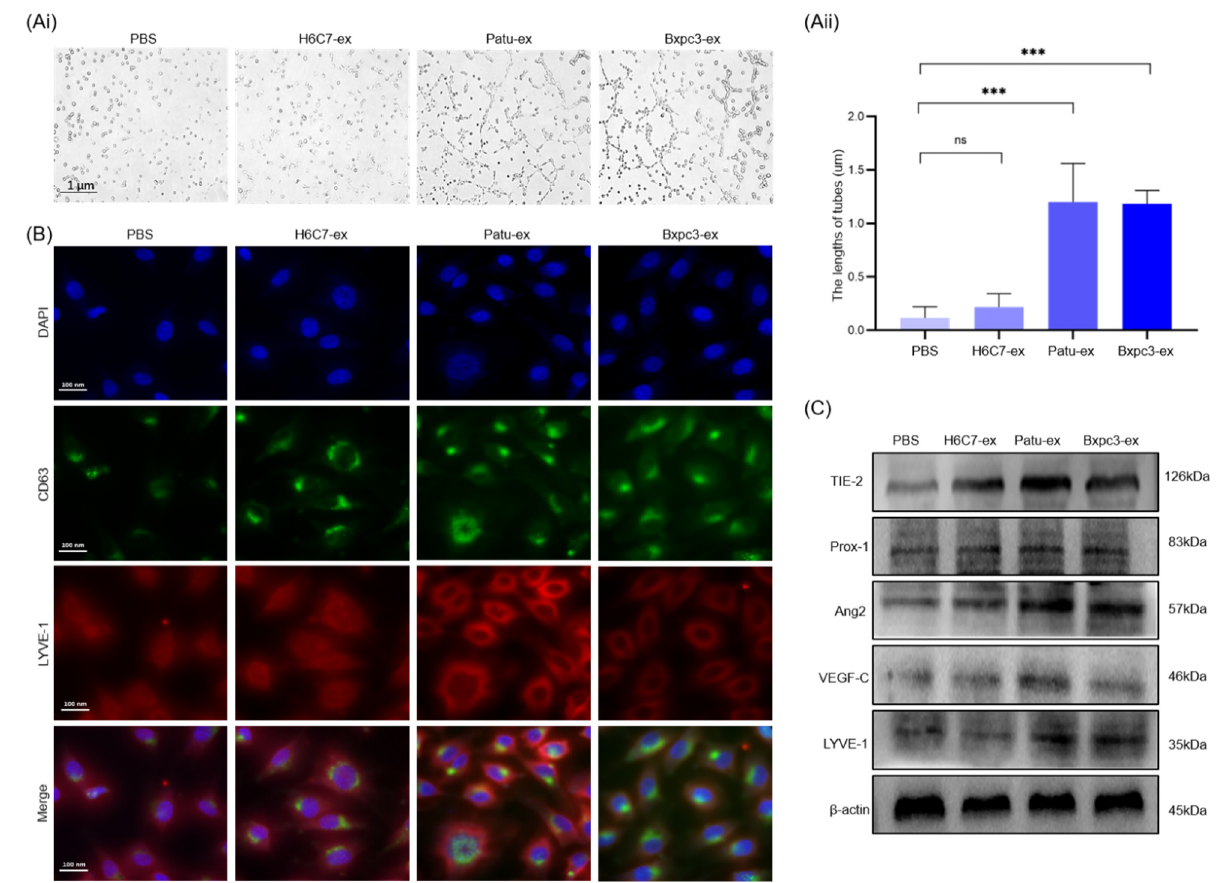
Figure 3. Exosomes from pancreatic cancer cells enhance lymphangiogenesis. ( Ai ) The tube-formation assay was conducted. ( Aii ) Statistical analysis of the tube-formation assay ( n = 3). ( B ) Immunofluorescence assay was performed to test the specific protein of the lymphatic vessel, LYVE-1, and the marker protein of exosomes, CD63, in the HLECs after cultivating with the exosomes. ( C ) The relative tube-formation protein in the HLECs, TIE-2, Ang2, LYVE-1, Prox-1, and VEGF-C. *** p < 0.001.